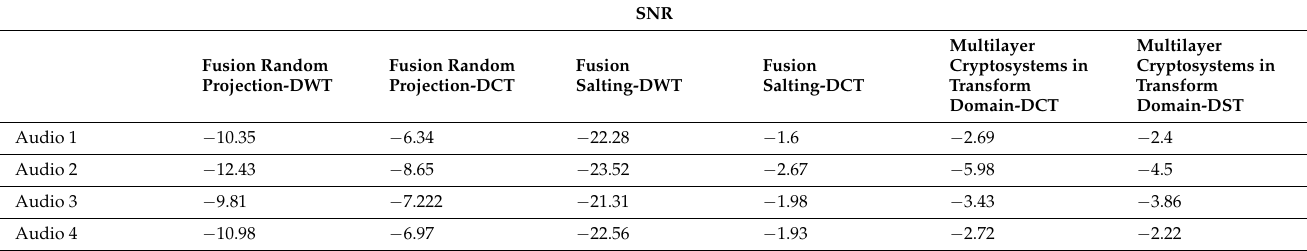
Table 7. Evaluation using four audio